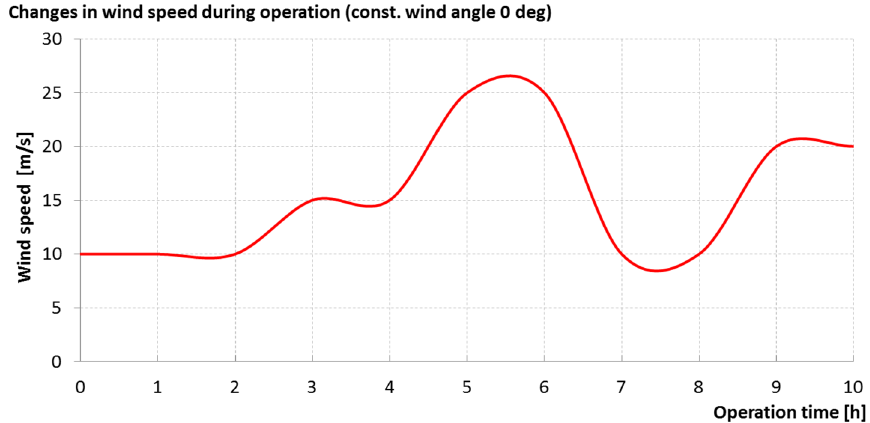
Figure 10. Wind speed changes during 10-h positioning.